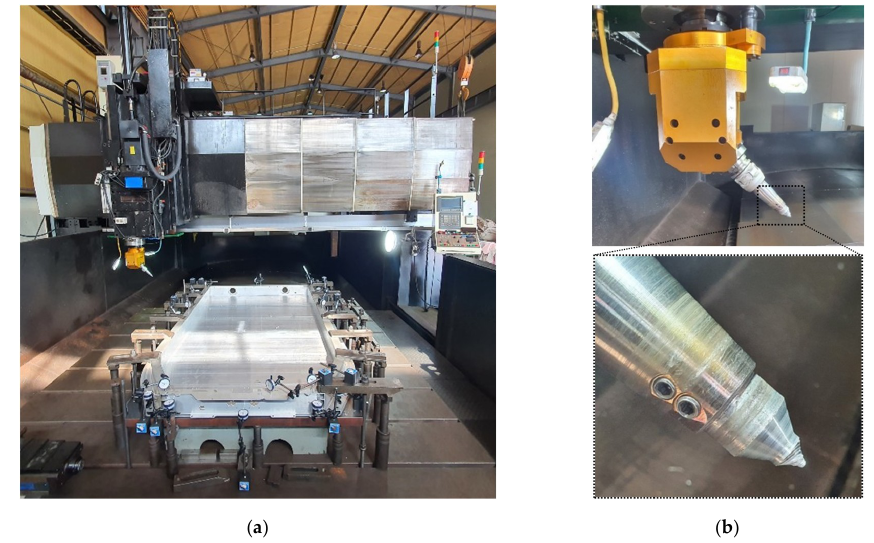
Figure 5. Fillet joint FSW equipment: ( a ) Actual full-frame structure set; ( b ) actual fillet FSW tool set.